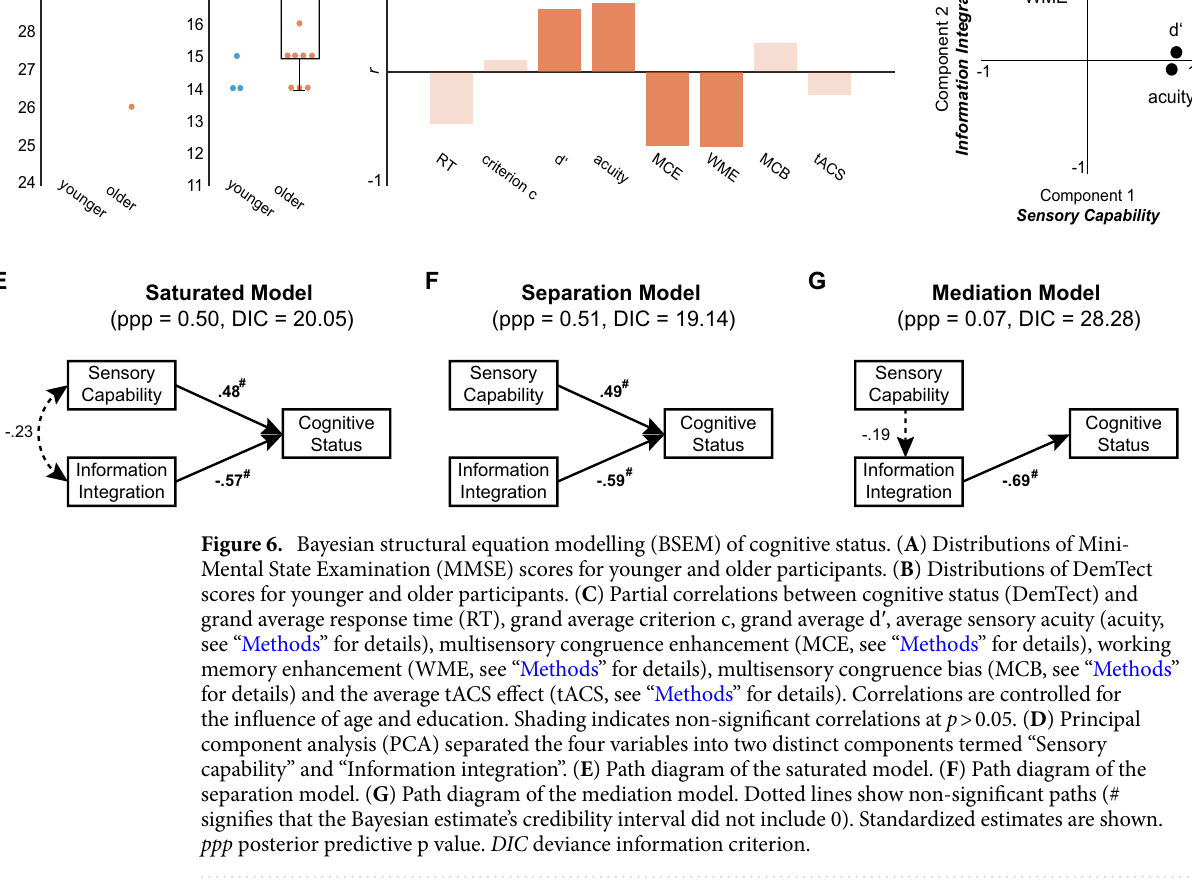
Component 1: “Sensory capability” (pattern matrix/ Variable structure matrix)